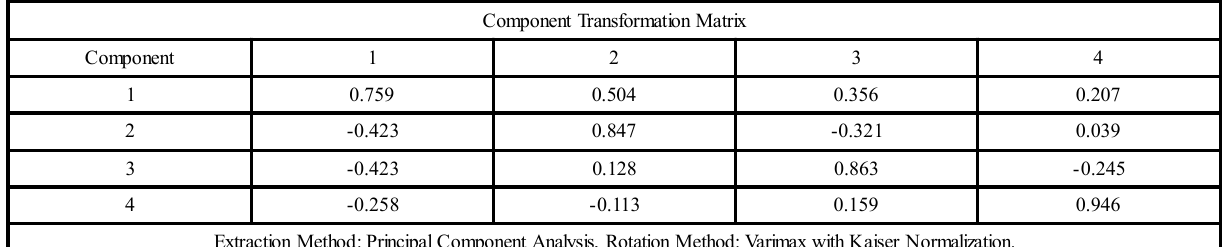
TABL 15. DETAILS OF COMPONENT CORRELATION